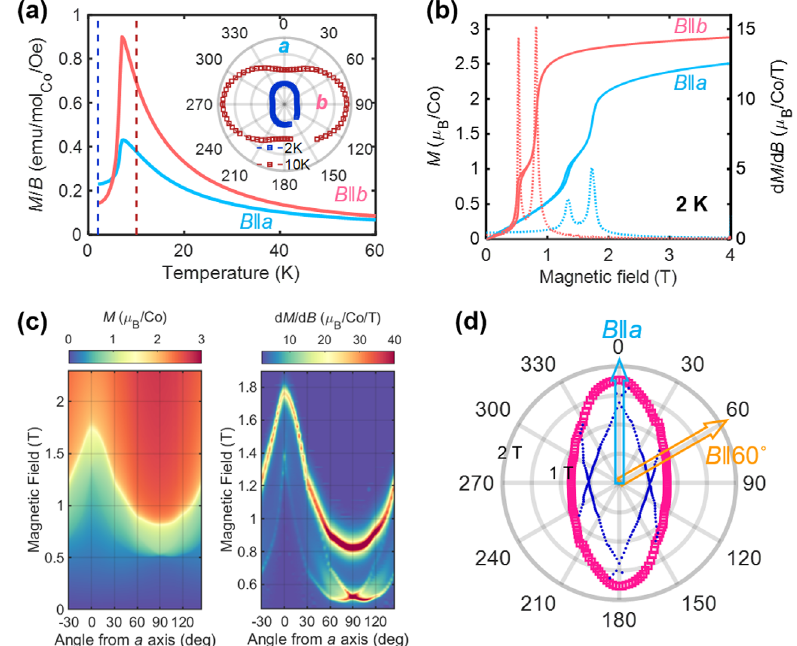
FIG. 2. (a) dc magnetic susceptibility measured in fields of 0.1 Talong the a and b axes. The inset displays the susceptibility versus in- plane angle at 2 and 10 K (dashed lines in the main panel), showing highly pronounced C 2 profiles which reverse the long and short axes across T . (b) Magnetization versus field data (solid lines) reveal two transitions along both a and b at 2 K. The critical fields ( B N B ) are determined from the derivative (dashed lines) as (0.82, 1.76 T) for a and (0.52, 1.37 T) for b , with an uncertainty of (cid:4) 0 . 02 T. c 2 Data are displayed for both field-up and -down sweeping directions, which are nearly identical except near B nature of the transition. (c) In-plane angle dependence of magnetization versus field (left) and the field derivative (right) at 2 K. Measurement at each angle is performed over a field-up sweep, and the field is decreased to zero before moving to the next angle. It is seen that B splits away from a and b . (d) Summary of the result in (c) after 180° symmetrization. Empty arrows are a reference for the c 1 field directions in Fig.